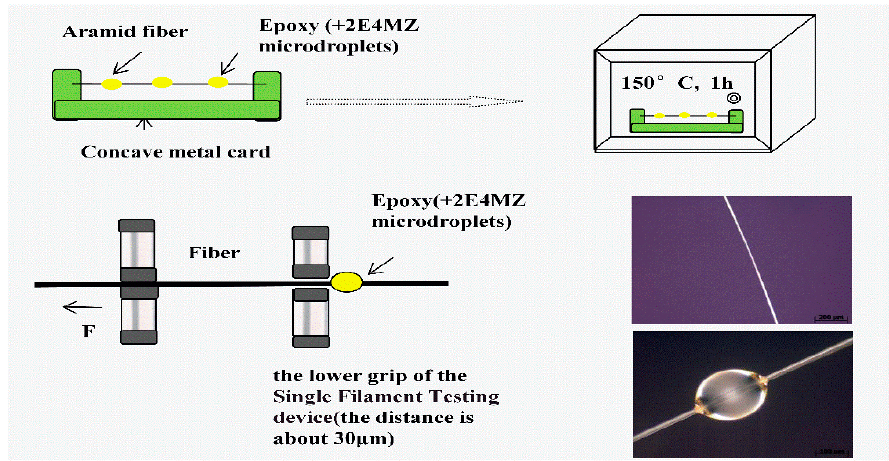
Figure 4. Micro-droplet test.